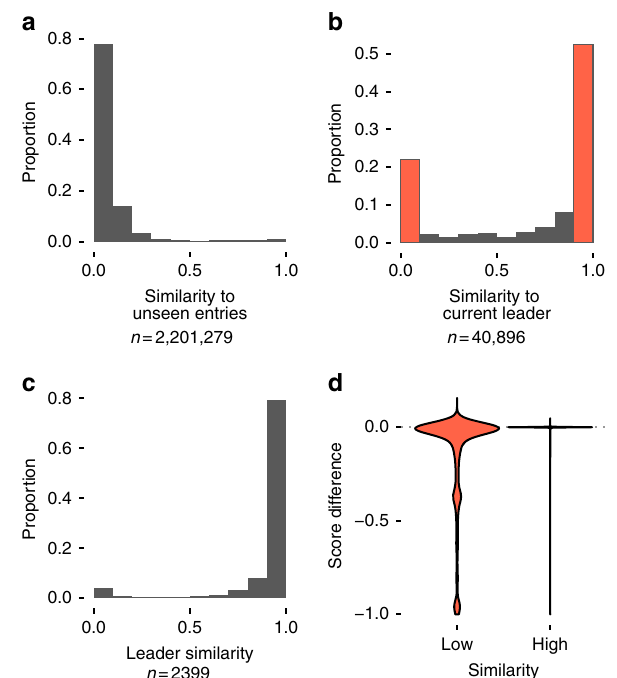
Fig. 2 Similarities across all contests. Proportion of similarities a between all entries under limited visibility conditions (i.e. when players only had access to their own entries — see Supplementary Methods; n = 2,201,279); b of all entries to the current leader at the time when the entry was submitted (red indicates tweaks and leaps, with score difference plotted below; n = 40,896); c of that subset of entries that took the lead when entered to the previous leader ( n = 2399). d Score difference for entries with low similarity (<0.1) and high similarity (>0.9) to the current leader — score differences for highly similar entries are narrowly distributed around 0, while low similarity entries show wide variance ( n =